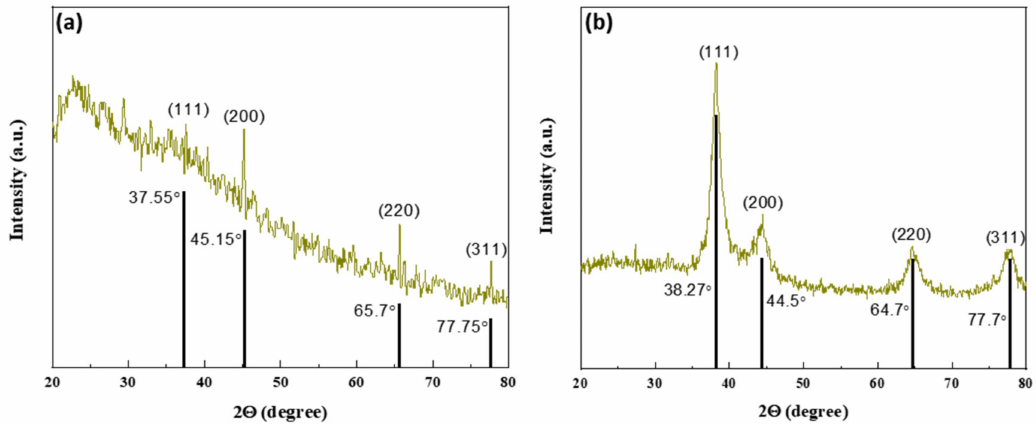
Figure 4. XRD patterns of Annona squamosa mediated AgNPs along with standard silver patterns ( a ) leaf extract, and ( b ) fruit extract.